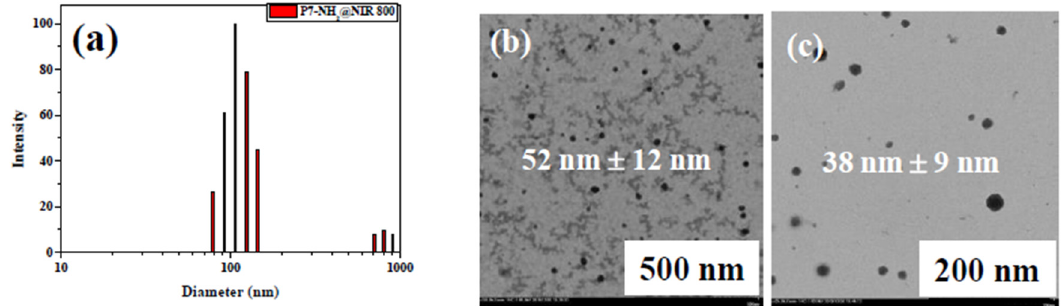
Figure 5. ( a ) Hydrodynamic diameters of P7-NH 2 @NIR 800 micelles; TEM images of ( b ) P7 and ( c ) P7-